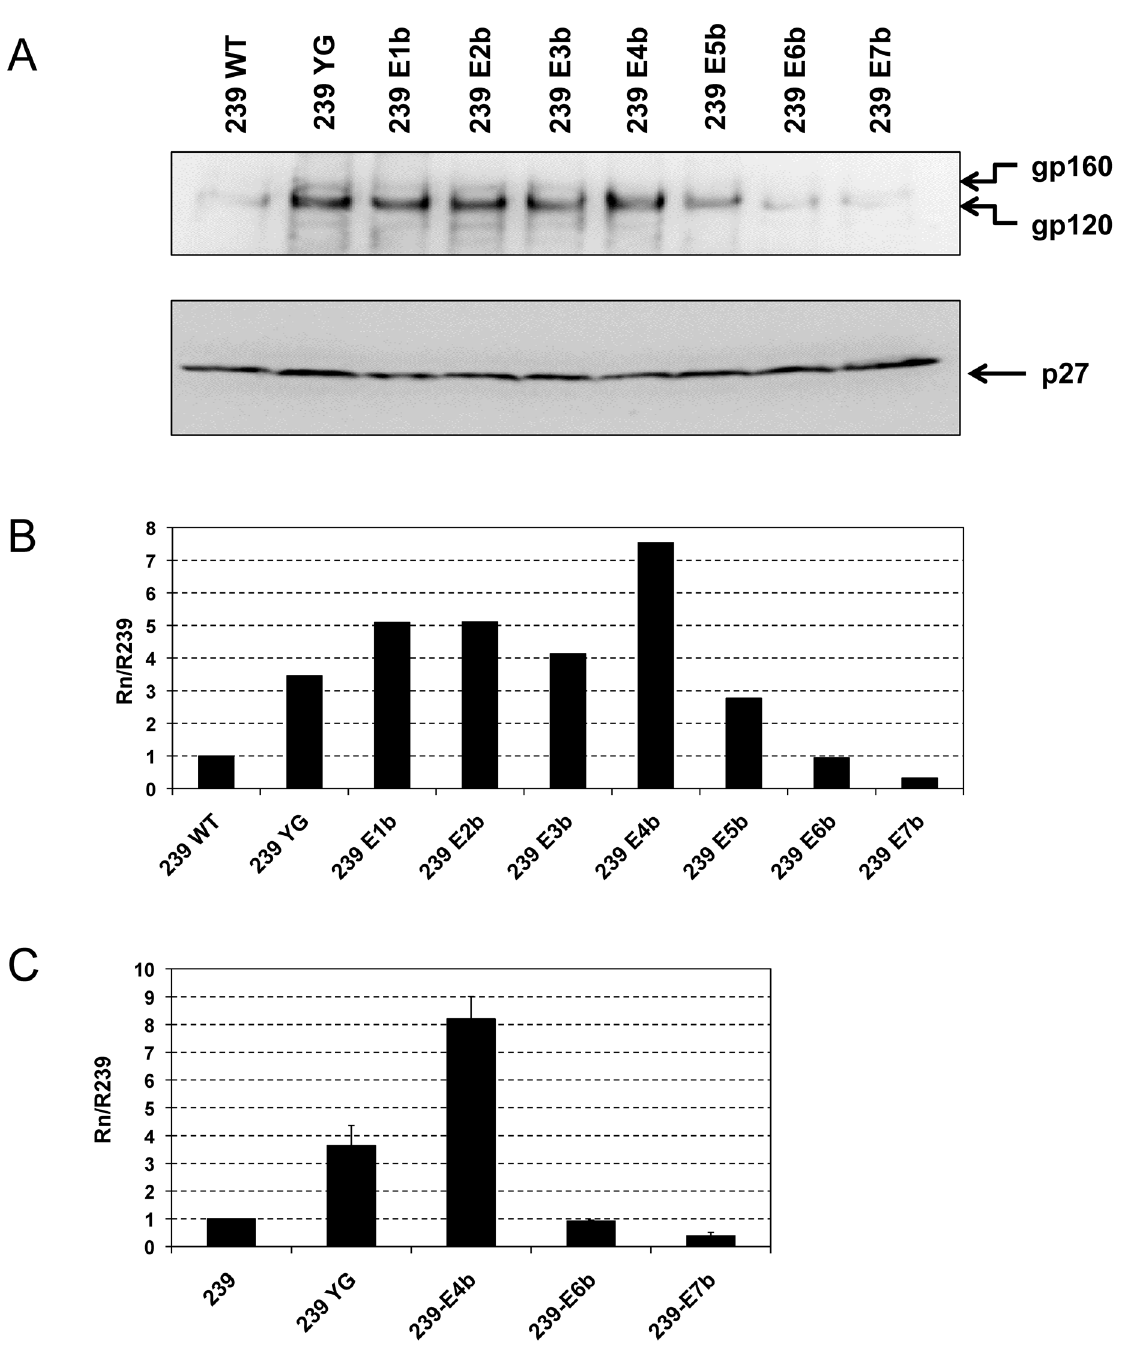
Figure 4. Mutation of potential trafficking motifs affects virion incorporation of SIVmac239 Env. Viruses were produced by transfection of HEK293T cells and virions were pelleted from the clarified supernatants. ( A ) gp160/gp120 (top panel) and p27 (bottom panel) were detected by Western blot using antibody 3.11H and 2F12, respectively. ( B ) Relative Env incorporation into virions. The ratios of gp120 to p27 were calculated by phosphorimaging analysis. Data are presented as the gp120:p27 ratio of mutant virions (Rn) relative to the gp120:p27 ratio of SIVmac239 wild-type (WT) virions (R239). (C) Mutants YG, E4b, E6b and E7b were quantified in triplicate. Shown is the average of independent experiments, error bars indicate standard deviation.